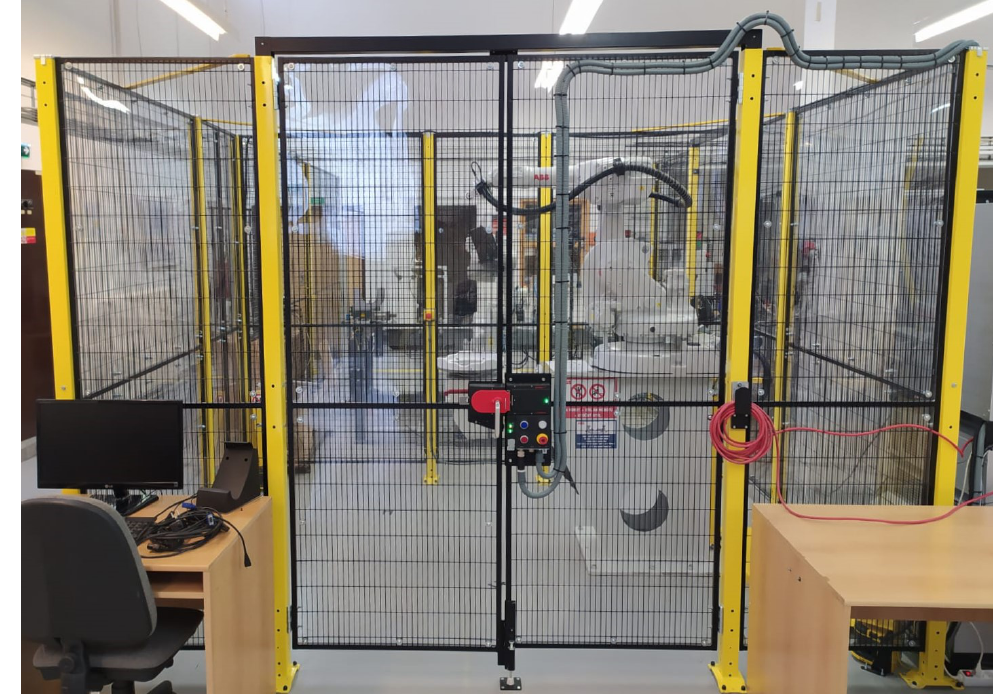
Figure 1. The picture shows a robot cell with an ABB IRB1600